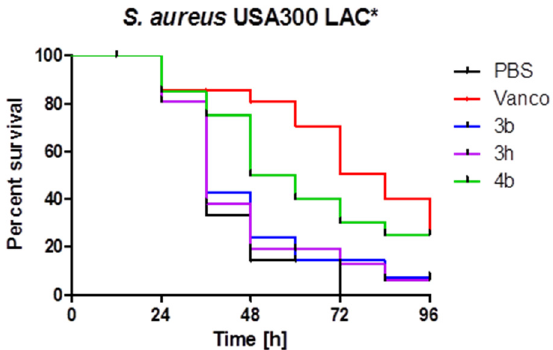
Figure 1. Survival of Galleria mellonella when infected with S. aureus strain USA300 LAC* and treated with 3b , 3h , 4b or controls (phosphate-buffered saline (PBS), vancomycin), respectively (Kaplan-Meier